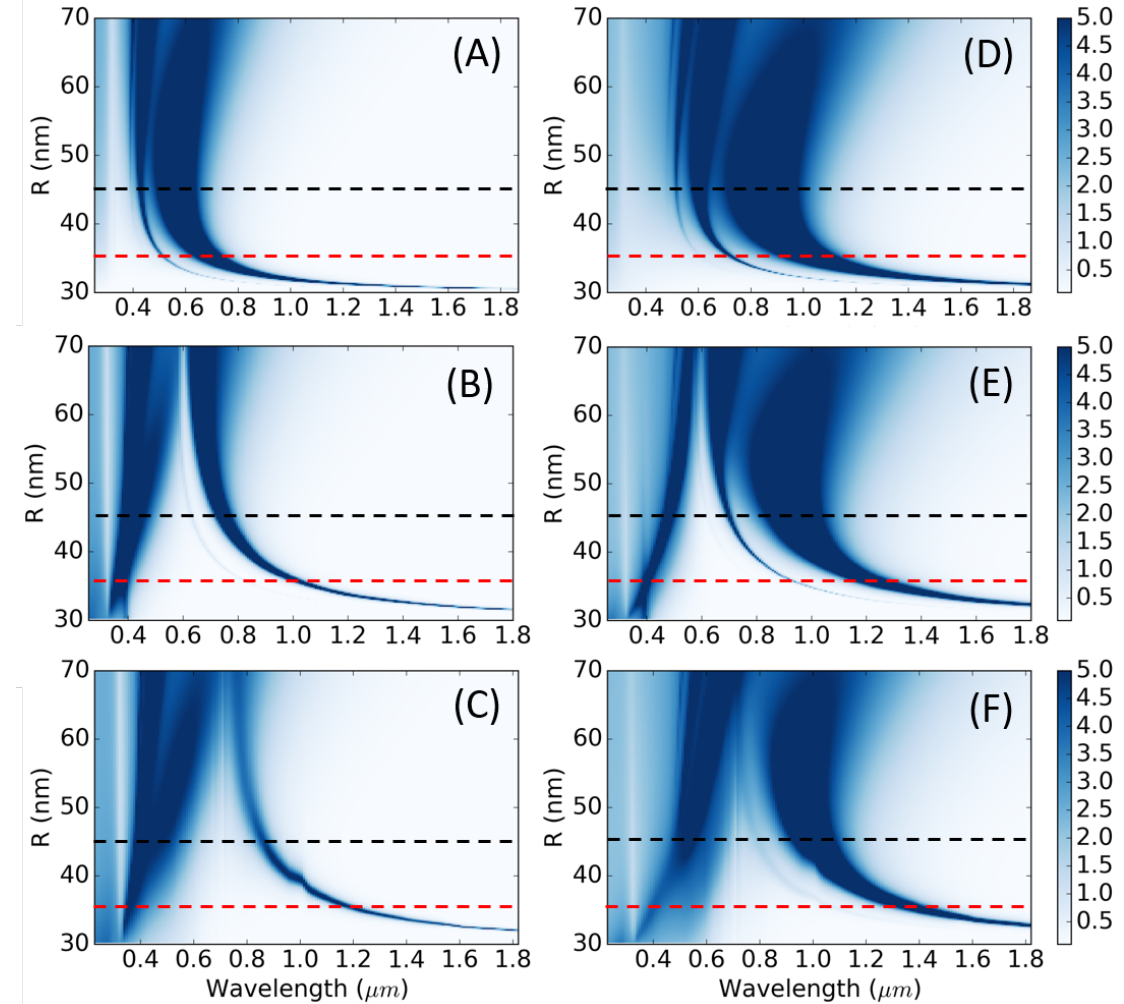
Figure 4. The extinction efficiencies as a function of the total radius R and wavelength λ for different core materials and an identical shell material (Ag). The core radius is fixed at r = 30 nm and total radius varies from 30 to 70 nm. In panels ( A – C ) the particles are embedded in a medium with a refractive of 1.5 and the core material is ( A ) vacuum, ( B ) Si, and ( C ) Ge. In panels ( D – F ) the particles are embedded in a medium with a refractive index of 2.4 and the core material is ( D ) vacuum, ( E ) Si, and ( F ) Ge. The intensity of the blue color represents the magnitude of Q ext as indicated in the side